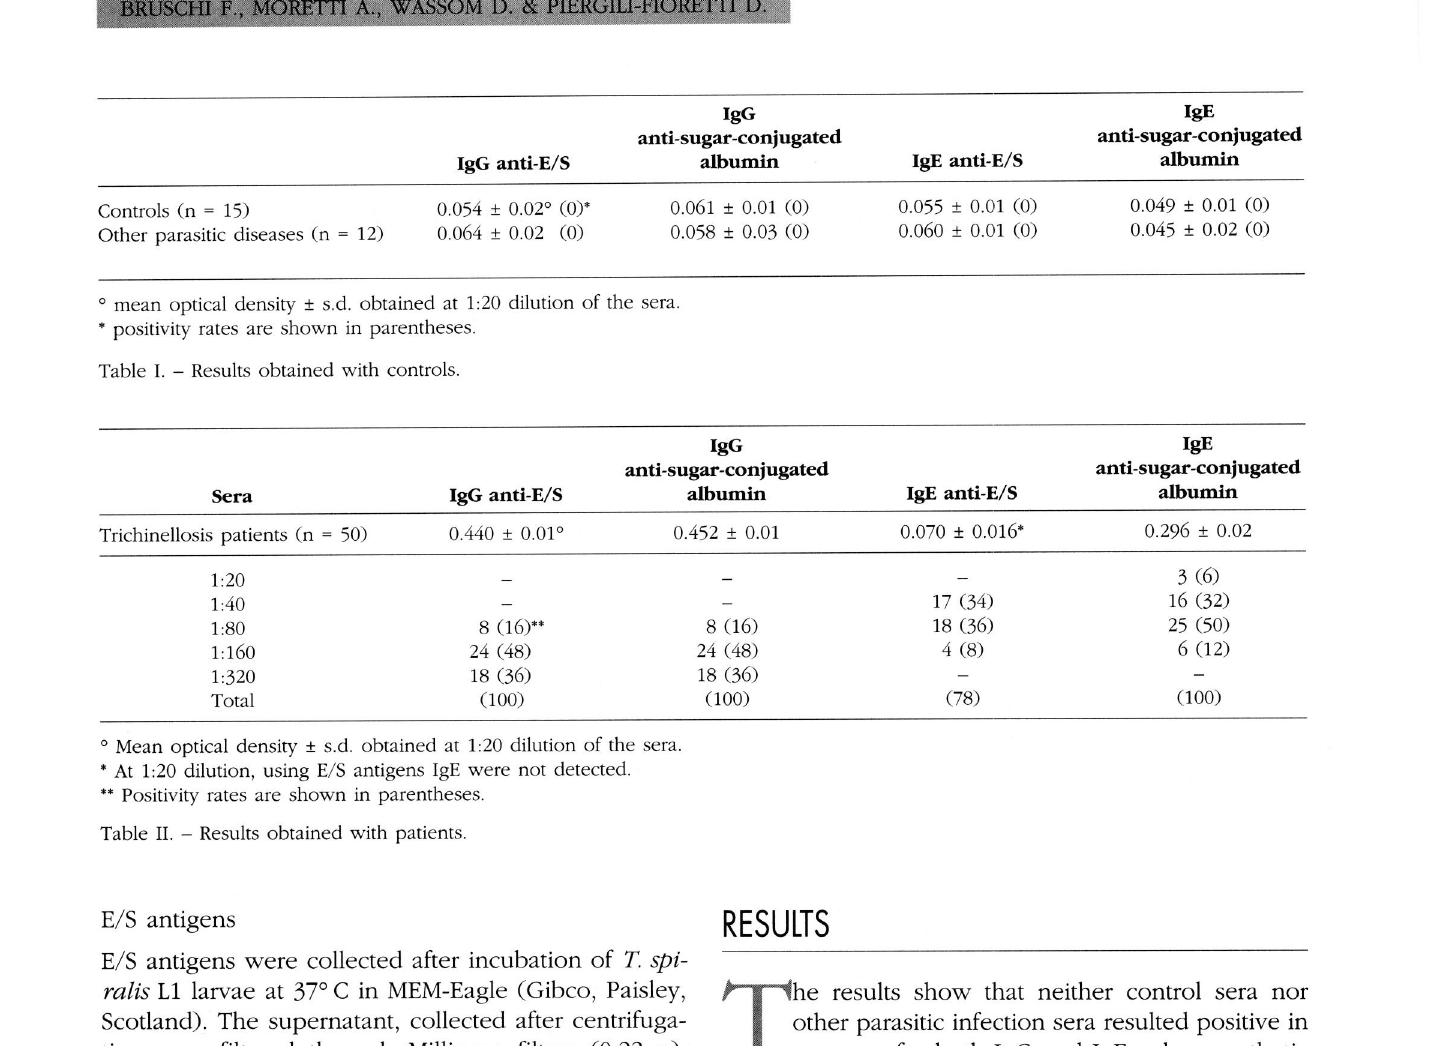
Table II. - Results obtained with